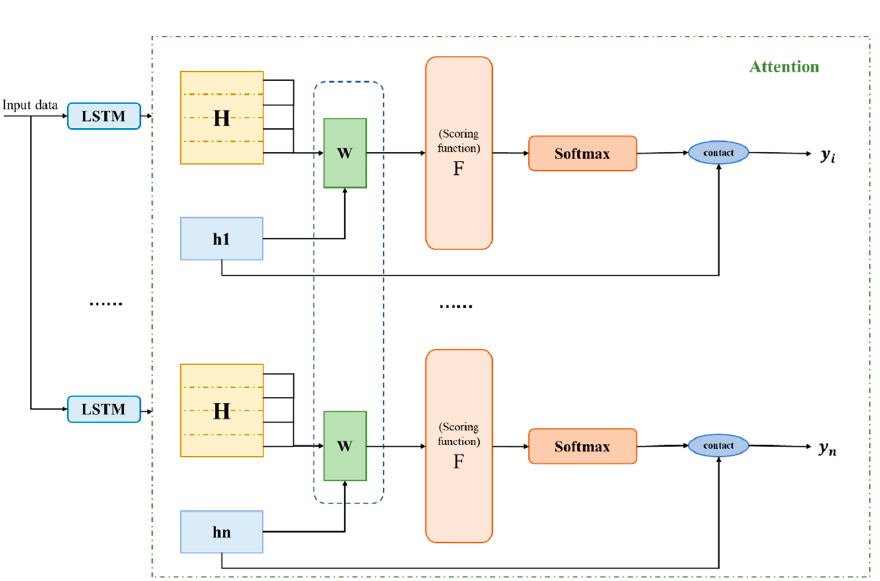
Figure 6. Schematic diagram of periodic time series data attention.